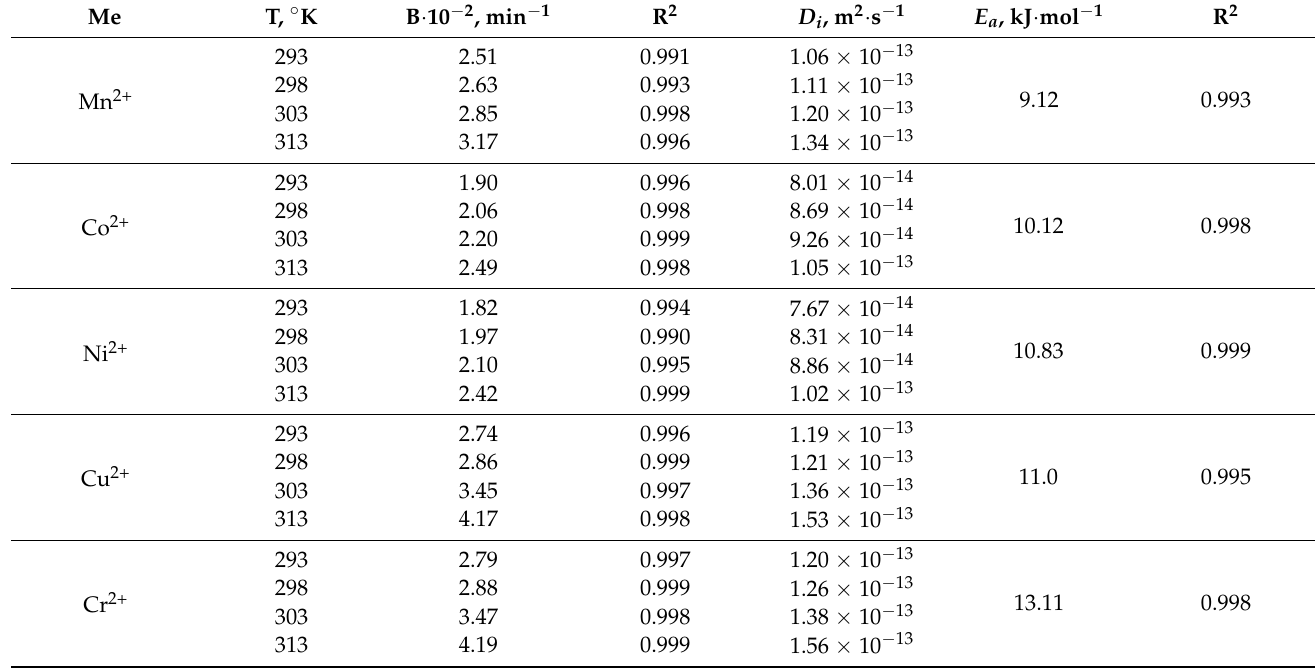
Table 1. Kinetic parameters of the intraparticle diffusion model for sorption of studied ions on Li-TiOP sorbent at different temperatures.